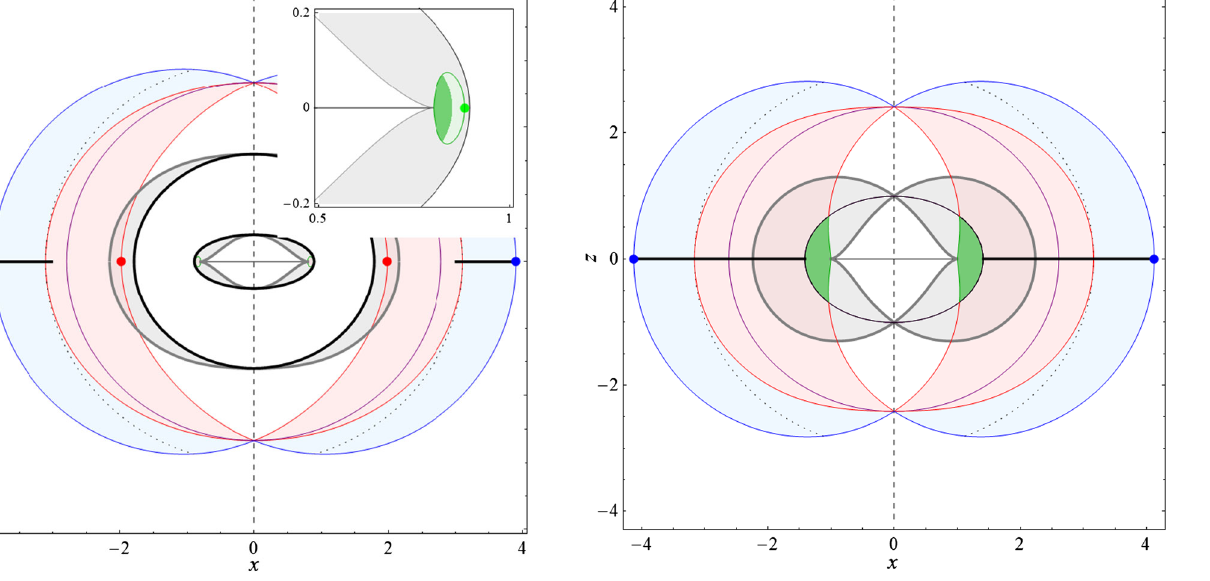
Fig. 15 Structure of the SPOs in the KBH spacetime with a = 0 . 8 corresponding to the Class I. Colouring is as in Fig. 14 - in green it is depicted the region of the spherical orbits with negative energy E , in red the region of photon prograde motion in the azimuthal direction, and in blue the region of the retrograde azimuthal motion. Note that not all the orbits are purely prograde, nor purely retrograde, but can have a turning point of the azimuthal motion, hence the colouring of a particular curve representing some fixed Boyer-Lindquist radius r can be change. Full/light hues correspond to stable/unstable orbits. Grey shading demarcates the area where g tt ≥ 0 (ergosphere), grey curve is its boundary (ergosurface). Purple curve is the polar orbit. Loci of turning points of the azimuthal motion are designated by red curves, loci of turning points of the latitudinal motion are distinguished by blue curves. In all figures some outstanding radii are highlighted, namely r = 1 (full black ellipse), r = 3 (black dotted incomplete ellipse). The ring singularity is depicted by the horizontal abscissa, the spin axis by the vertical dashed line. The bold dots represent the photon equatorial circular orbits, namely, the co-rotating orbits with negative energy E < 0 (green), the co-rotating orbits with E > 0 at r = r ph + (red), and the counter-rotating orbits at r = r ph − (blue). In addition, we included images of a possible Keplerian accretion discs, represented by the first family of the equatorial circular orbits of the test particles [40] (bold black horizontal abscissas). Their inner edge is the marginally stable circular orbit